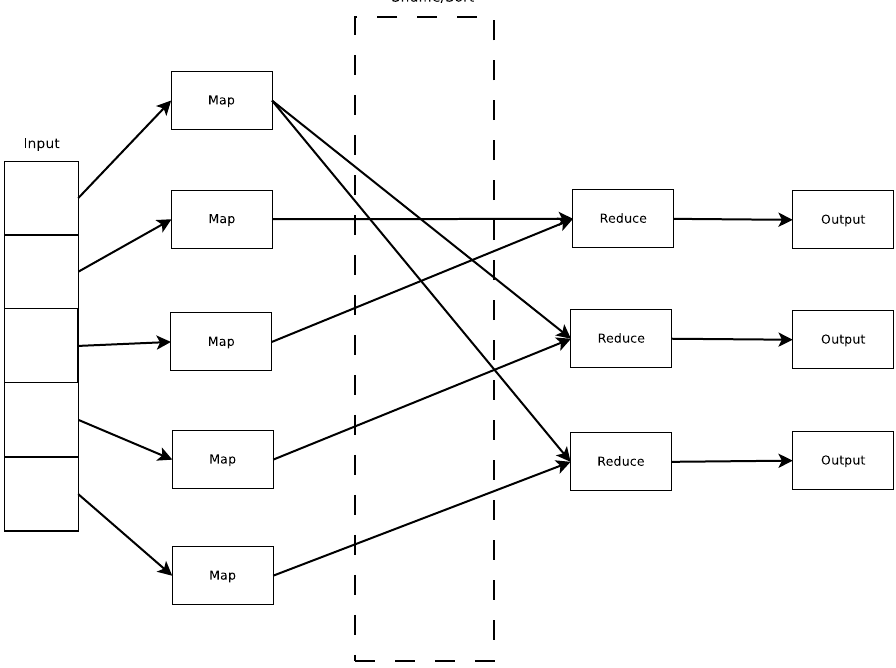
Figure 1. Architecture of MapReduce